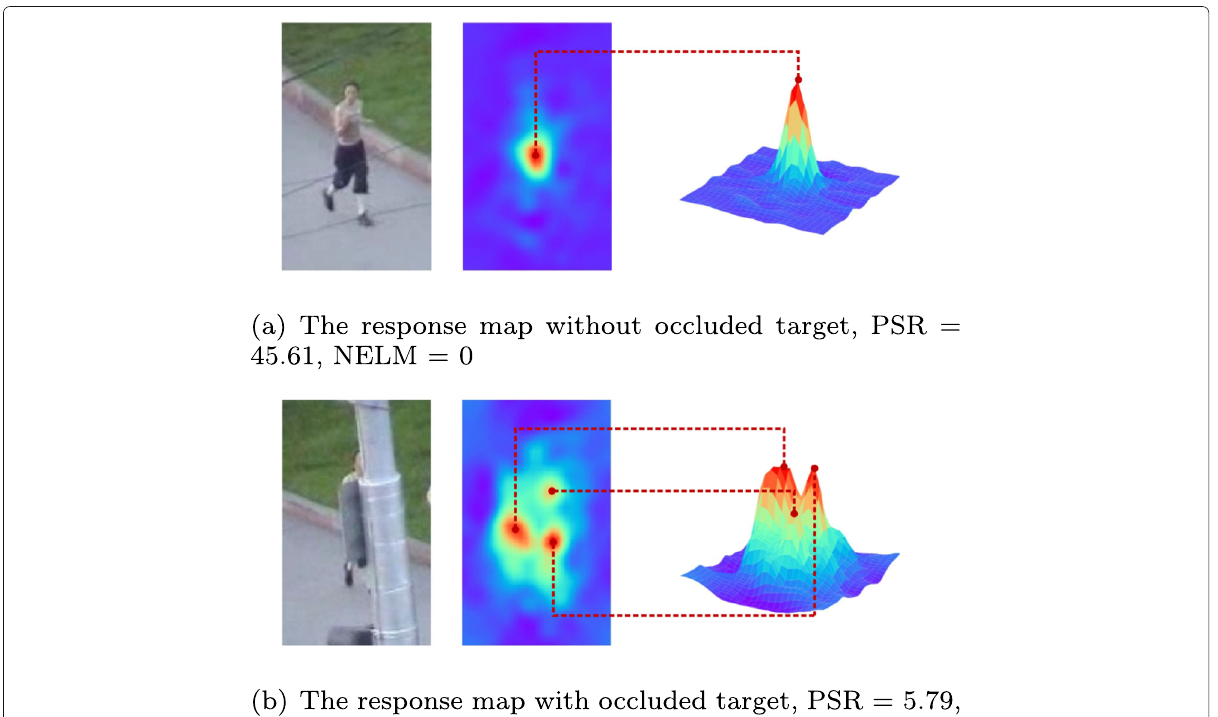
Fig. 4 The response maps with and without target occlusion. The red dotted lines show the locations of the local maxima in the 3D response map. Notice that, NELM does not count the global maximum, so NELM less than the number of dotted lines. a The response map without occluded target, PSR = 45.61, NELM = 0. b The response map with occluded target, PSR = 5.79, NELM =